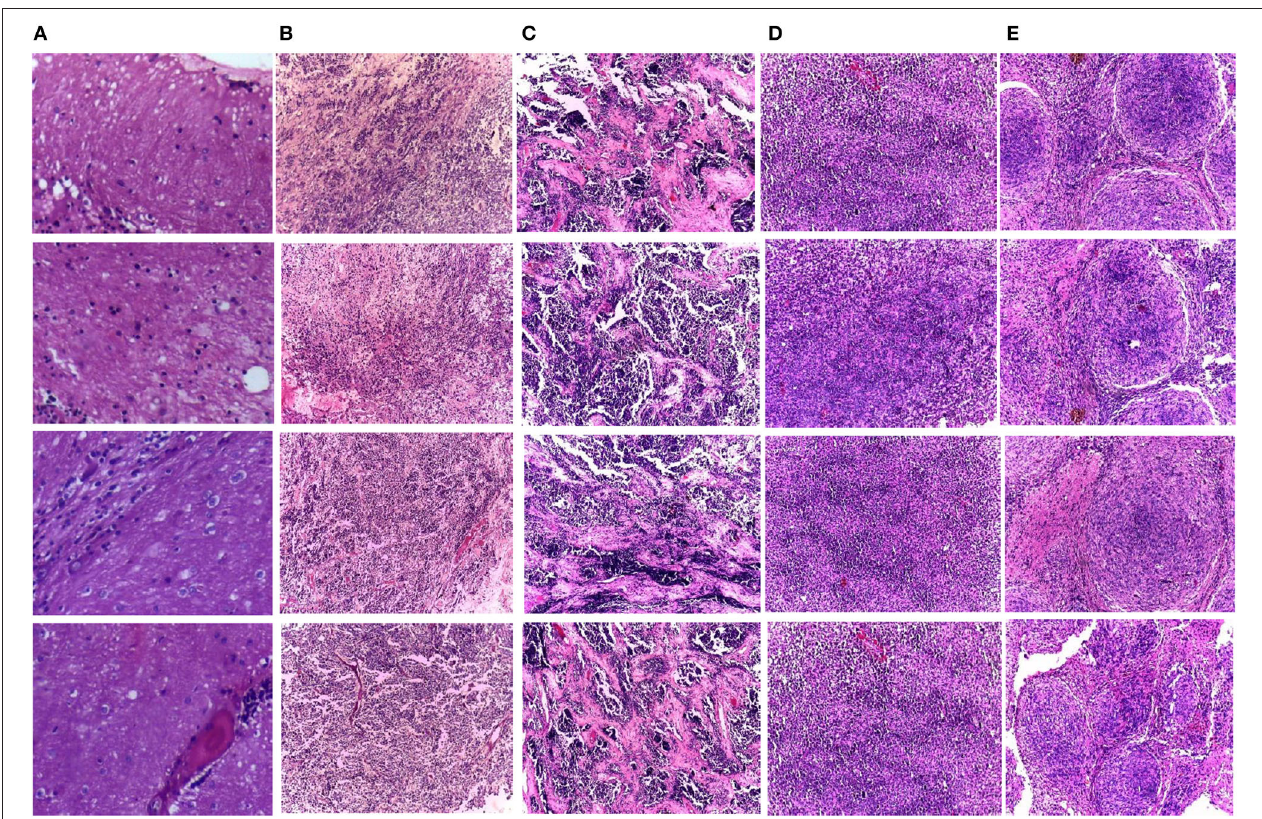
FIGURE 1 | Samples of the childhood pediatric MB images, (A) normal, (B) classic, (C) desmoplastic, (D) large cell, (E)